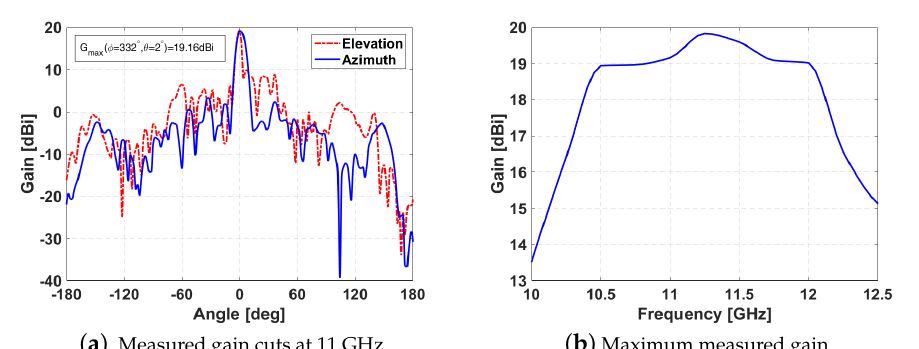
Figure 10. Reflectarray characterization results.